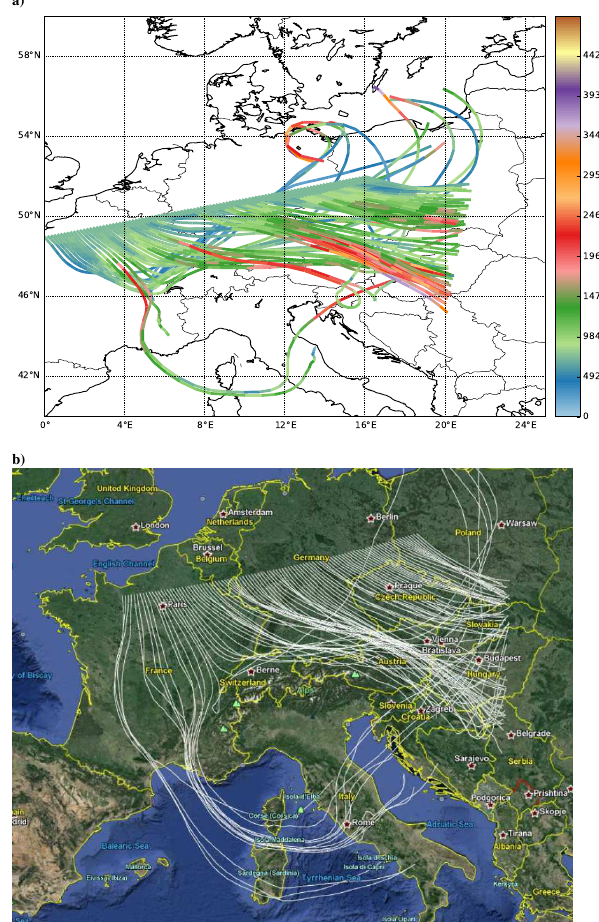
Figure 7. (a) 48h forward trajectories started at 09:00UTC on 28 January 2009 along a line north of the Alps (as in Fig. 5d). The individual trajectories are colored according to their height (in m). The figure was created with the quickview visualization tool in- cluded in LAGRANTO (see Sect. 5.3). (b) The same trajectories as in panel (a) , but converted into KML format, which can then be added as a separate layer to a Google Earth